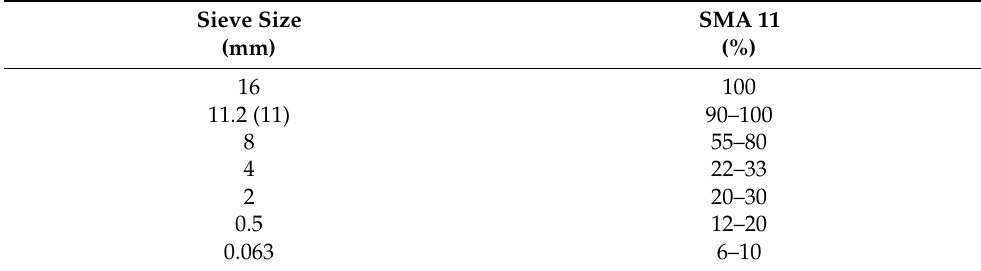
Table 1. Grading envelope of the selected asphalt